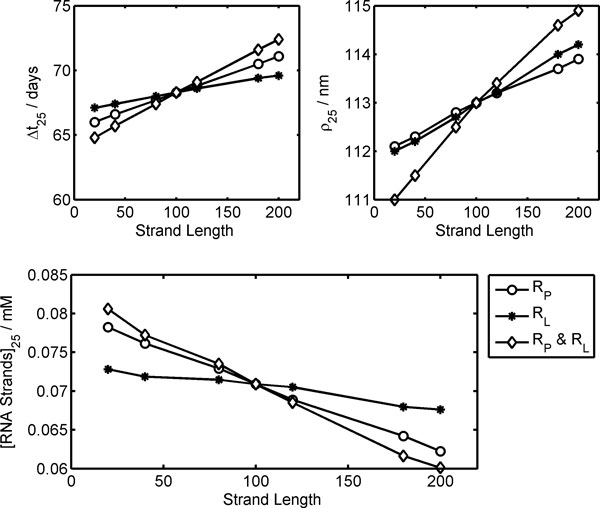
Influences of ribozyme length on the Ribocell stationary regime. Life time Δt25, radius ρ25 and RNA total strand concentration [RNA Strands]25 after 25 generations are reported against ribozyme length. The legend reports the ribozymes that are changed in size.